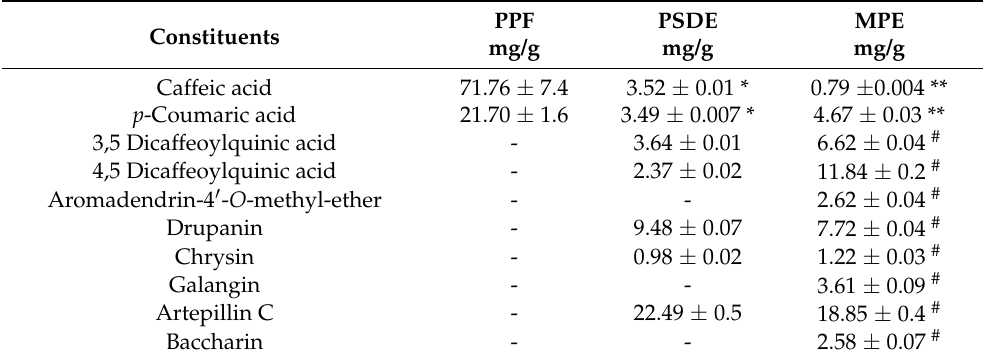
PPF = polar propolis fraction; PSDE = soluble propolis dry extract; MPE = microencapsulated propolis extract. (*) Significantly different from PPF and MPE (one-way ANOVA, with Tukey’s post-test, p < 0.05); (**) Significantly different from PPF and PSDE (one-way ANOVA, with Tukey’s post-test, p < 0.05); ( # ) Significantly different from PDSE (Students t -test, p < 0.05); n = 3, mean ± standard